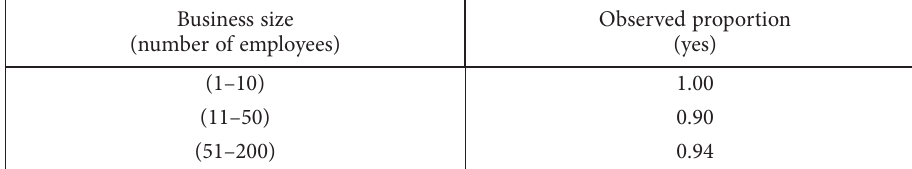
Table 3. Pivot table: the hypothesis (H2) according to business size (source: created by authors) Business size (number of